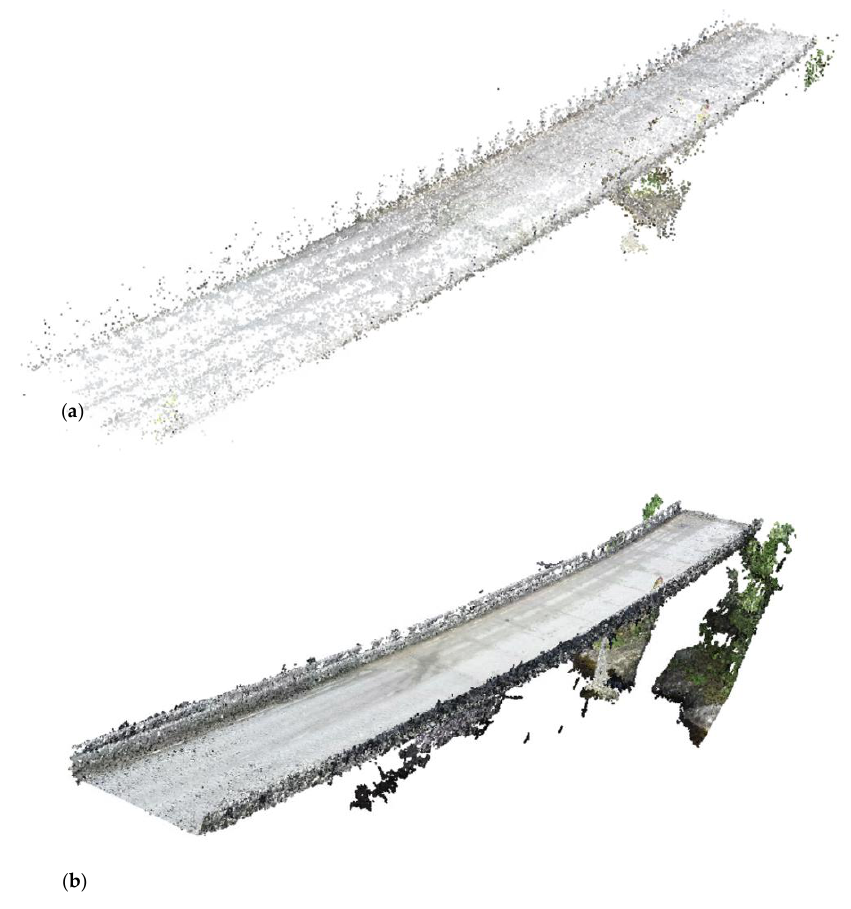
Figure 7. ( a ) Bundle adjustment for Skodsberg Bridge, ( b ) Skodsberg Bridge dense matching.